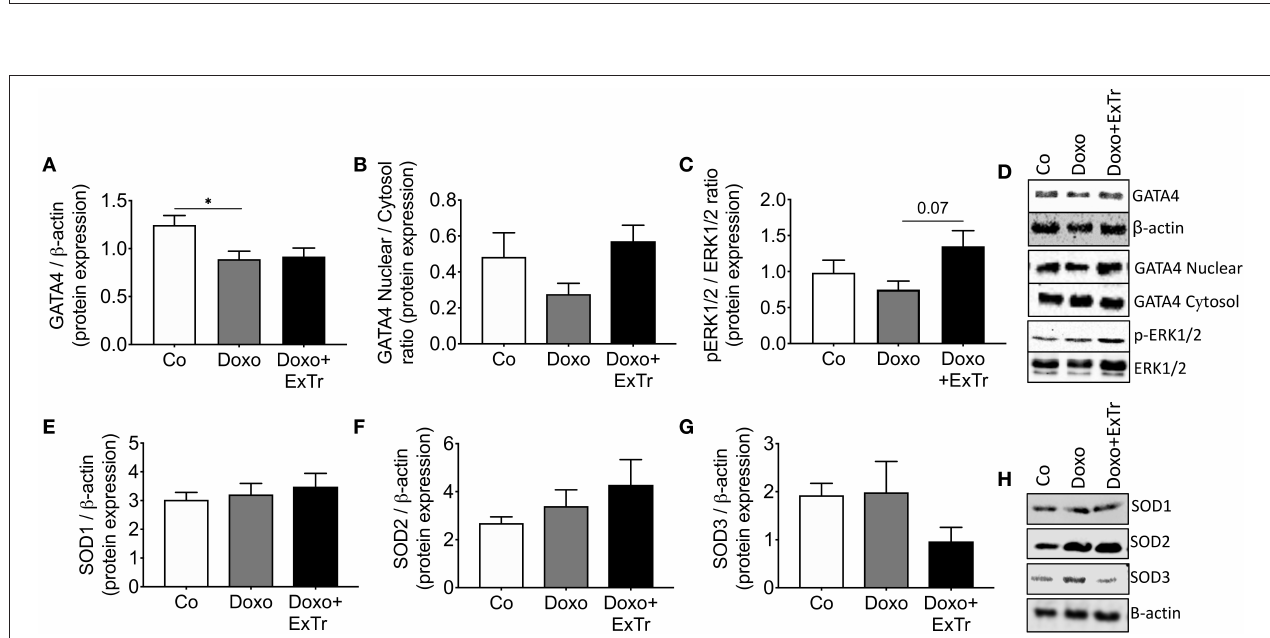
FIGURE 4 | Molecular markers of Doxo-induced cardiotoxicity. Cardiac protein expression of GATA4 analyzed by densitometry and normalized against β -actin (A) and its nuclear/cytosol ratio (B) ; the ratio of pERK-to-total-ERK (C) and representative blots (D) ; protein levels of the antioxidant enzyme superoxide dismutase isoforms 1 (E) , 2 (F) , or 3 (G) and its representative blots (H) . GATA4, GATA binding protein 4; ERK, extracellular signal-regulated kinases; pERK, phosphorylated ERK; SOD, superoxide dismutase. Group abbreviations as in Figure 1 . n = 5–8 per group. * P ≤ 0.05.